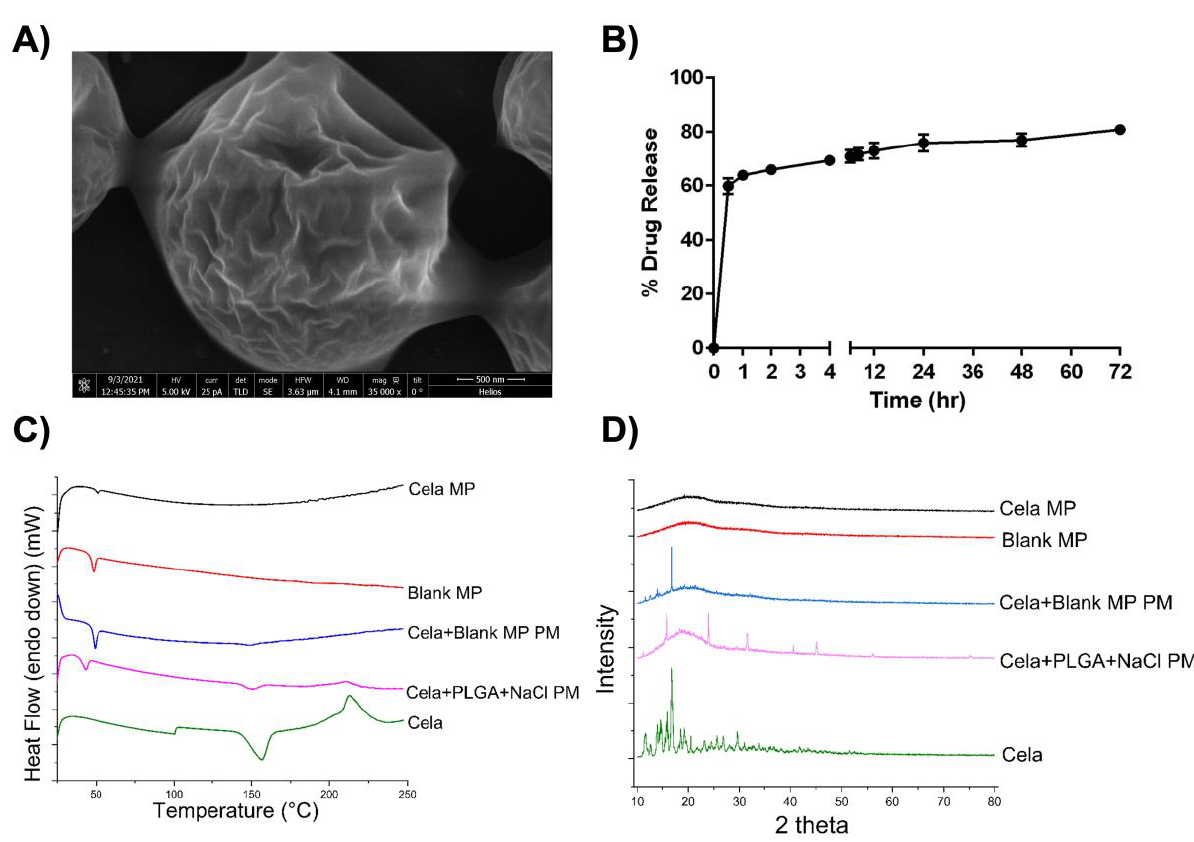
Figure 1. Imaging and physical characterizations of Cela MP. ( A ). SEM image showing a wrinkled surface with a ~2 µm diameter of Cela MP. ( B ). In vitro drug release of Cela MP in SLF with 1% SLS. Data represent mean ± SD (n = 3). ( C ). Overlay of DSC thermograms. ( D ). Overlay of XRD patterns of Cela, Cela + PLGA + NaCl physical mixture, Cela + Blank MP physical mixture, Blank MP, and Cela MP.